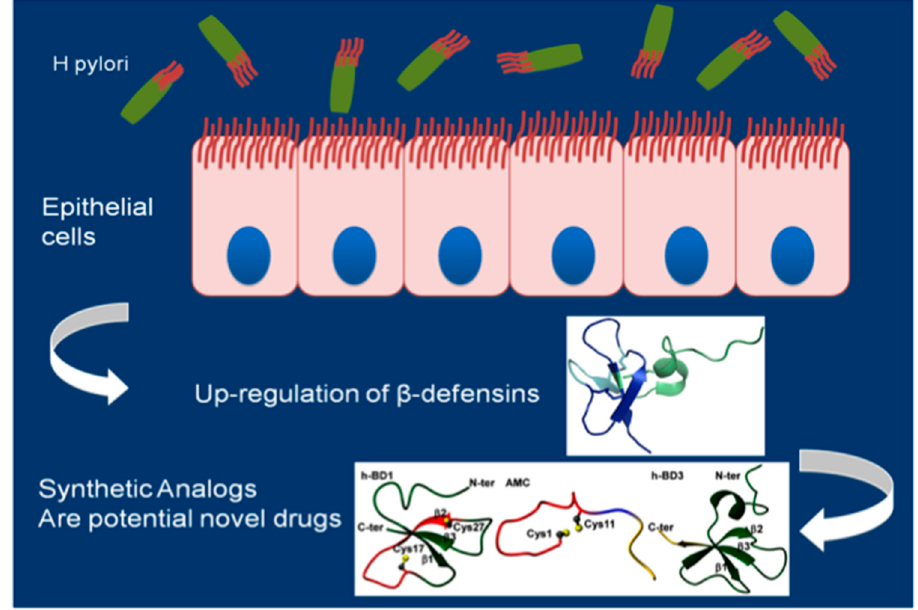
Figure 2. Schematic representation of β -defensins role in Hp infection. Hp infection leads to a significant induction of β -defensins that play a pivotal role in the immune response of the gastrointestinal epithelium to Hp infection, influencing and activating the adaptive immune system.